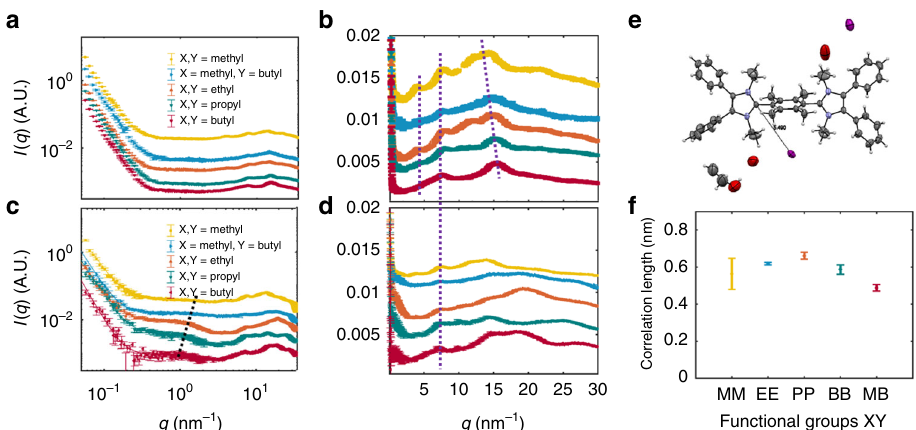
Fig. 6 X-ray scattering pro fi les of PAImXY(#) and X-ray crystal structure of 12 . X-ray scattering pro fi les of PAImXY( # )(I-) in vacuo ( a , b ) and hydrated ( c , d ). Figures in the left hand column ( a , c ) are plotted on a log – log scale to show overall structure. Figures in the middle column ( b , d ) are plotted lin – lin to focus on the wide-angle scattering (smaller structure). The curves are vertically offset for clarity. e X-ray crystal structure of model compound 12 in its iodide form (ellipsoid set at 50% probability) with distance of iodide to C2 represented by a line. f The size of the correlated regions observed in the hydrated samples with different side chains obtained by fi tting Equation 6 to the SAXS increases in length and may be caged within longer N-alkyl groups. Supplementary Figs. 32 – 36 show single-crystal unit cells with anion-imidazolium distances of 8.95, 5.14, 5.49, 5.28, 4.62 Å, respectively, for 10 , 11 , 12 , 13 , and 14 , respectively. The crystal structure of compound 12 is shown in Fig. 6e as an example here.